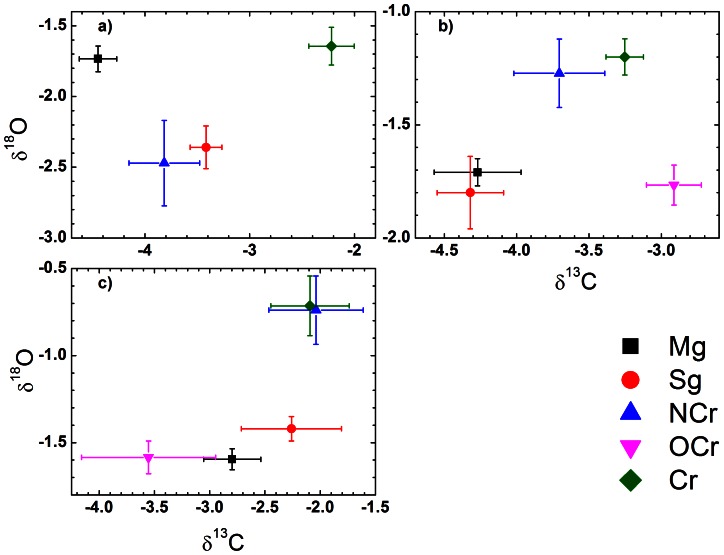
Mean (± SE) otolith δ13C and δ18O from the outer otolith margins of juvenile fish collected from mangroves (Mg) and seagrass (Sg) habitats, from the inner (juvenile) parts of otolith of adult fish collected from nearshore (NCr) and offshore (OCr) reefs, and from the outer otolith margins of coral reef adults (Cr), averaged per habitat for each of the species: a) Lethrinus harak, b) Lethrinus lentjan, and c) Lutjanus fulviflamma.